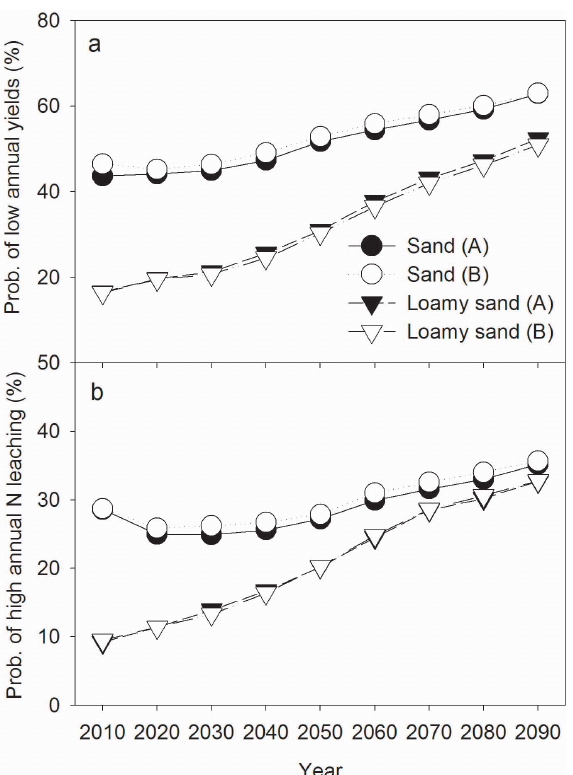
Fig. 5. Probability of yield reductions in individual years larger than 20% compared to mean yield simulated for baseline and probability of N leaching in individual years exceeding threshold levels of 50kgNha − 1 for loamy sand and 70kgNha − 1 for sandy soils. Results were calculated for projected climate conditions at 10-yr intervals during the 21st century for the A1B emission scenario using the two methodologies A and